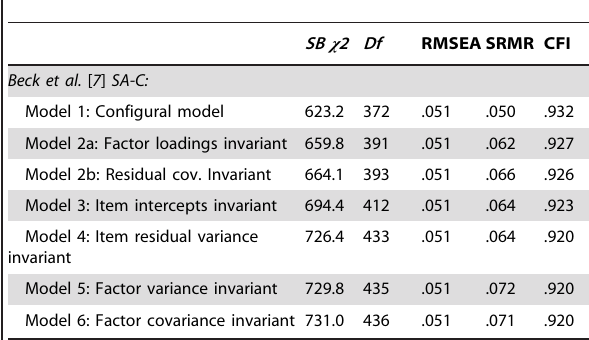
Table 3. Tests for measurement invariance across the sample without alcohol problems and the sample with comorbid alcohol problems for the SA-C model.